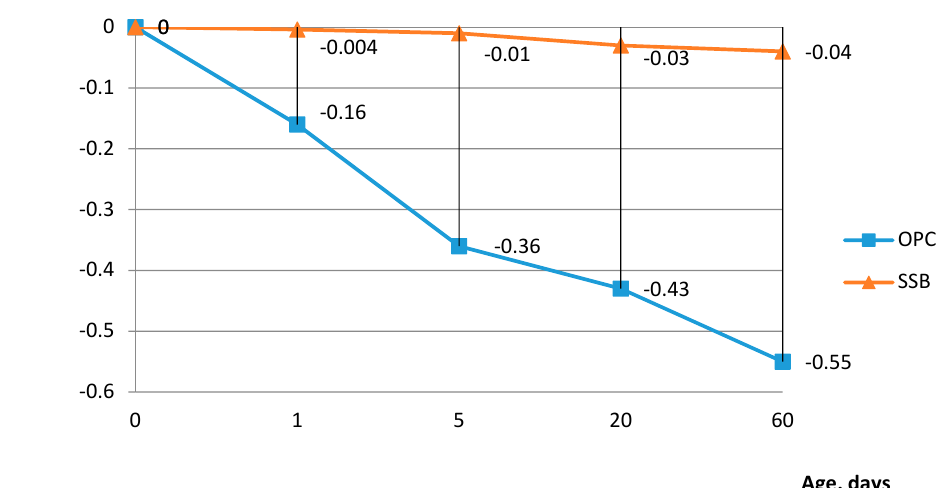
Figure 4. Shrinkage strain for long-term storage in air: SSB—supersulfated binder (composition 15-6000); OPC—Ordinary Portland cement (composition 15-cem).